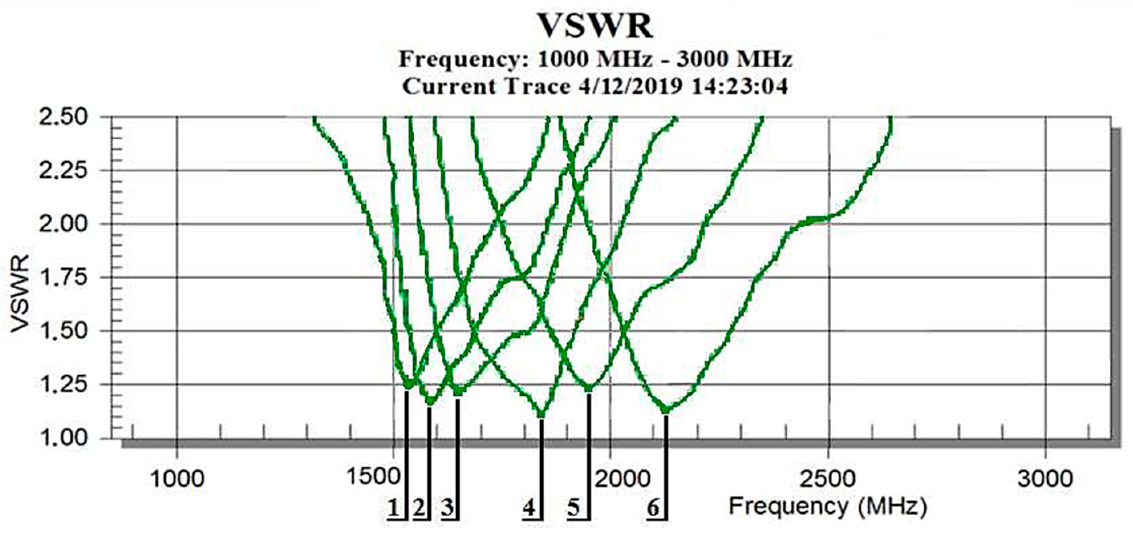
Figure 3. Example of one set of resonance frequencies of the antennas.